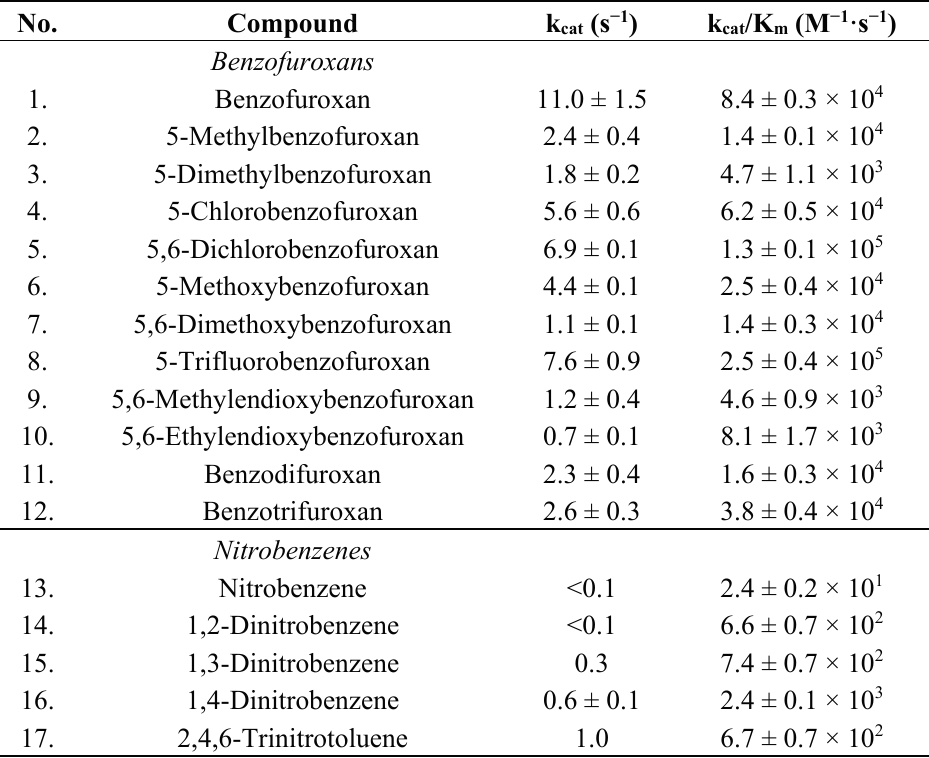
Table 3. The catalytic (k cat ) and the apparent second-order rate (k cat /K m ) constants of reduction of BFXs and NACs by NAD(P)H:quinone oxidoreductase (NQO1), pH 7.0, 25 °C. All kinetic measurements were performed at fixed concentration of NADPH (150